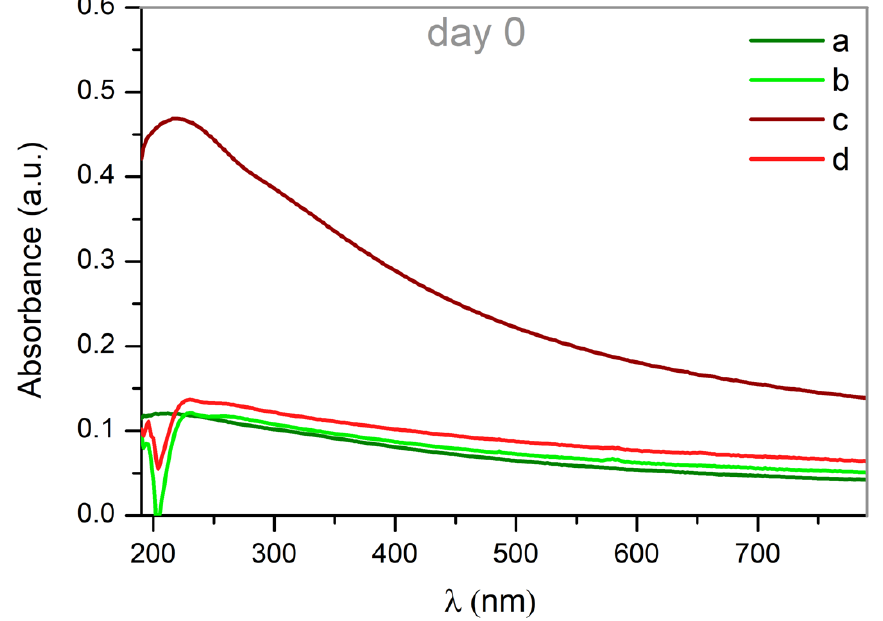
Figure 7. UV–VIS spectra of the as ablated palladium nanoparticles synthesized by laser with ( a ) 532 nm of wavelength in water, ( b ) 532 nm in methanol, ( c ) 1064 nm in water and ( d ) 1064 nm in methanol. The contribution due to the pure solvent has been subtracted from the spectra.